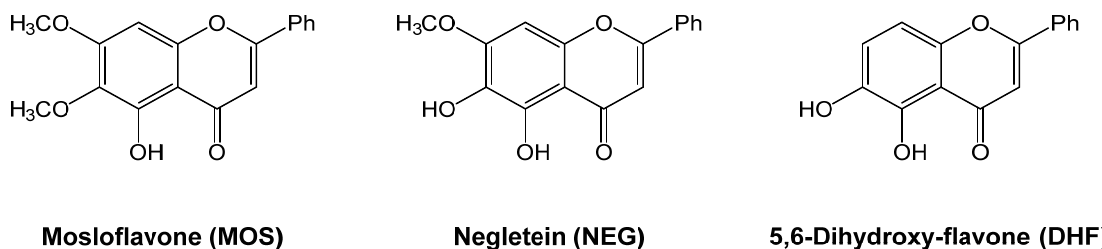
Figure 1. Structure of the studied polyphenolic flavones.